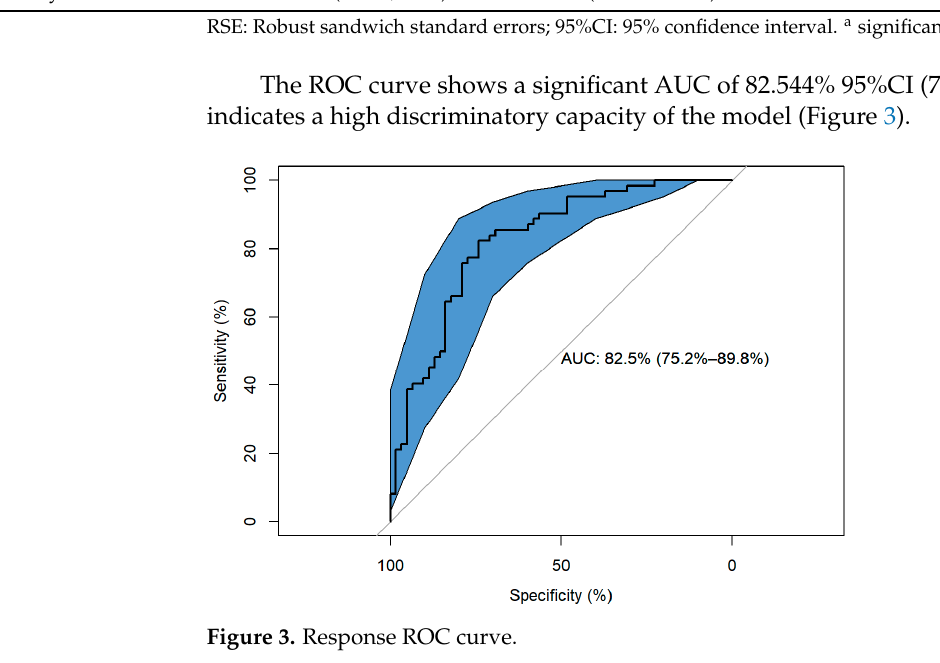
Figure 3. Response ROC curve.